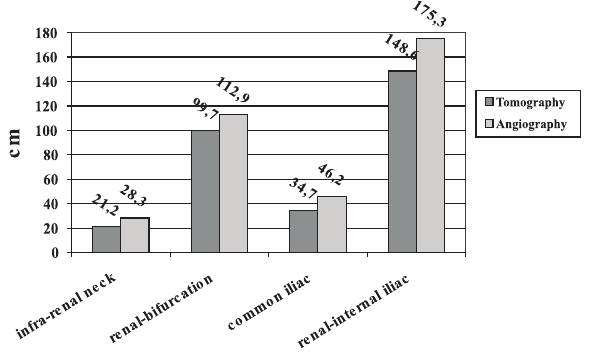
Fig. 3 - Comparative graph of the mean lengths measured by spiral TC and by angiography